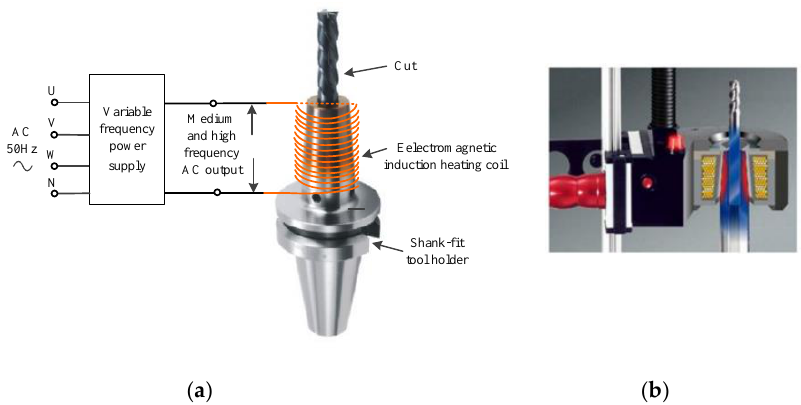
Figure 1. Induction heating diagram and section of the coil structure: ( a ) illustration of the induction heating principle; and ( b ) cross-section of the coil structure.